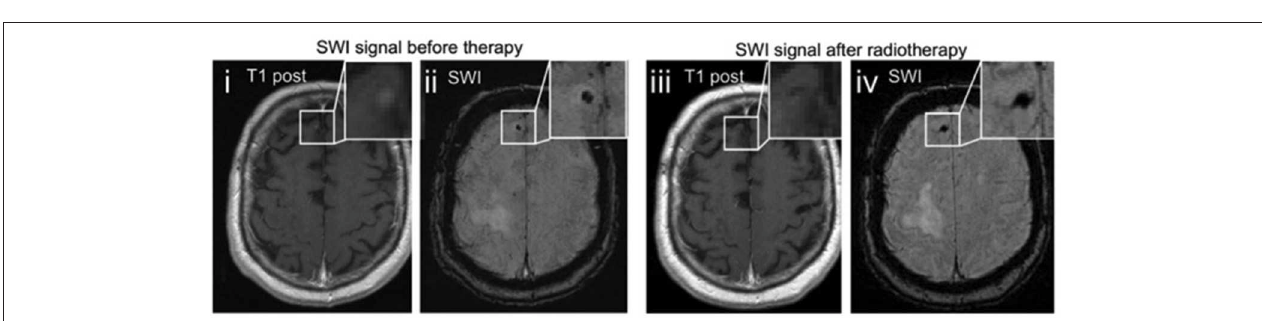
FIGURE 2 | Melanoma metastases and susceptibility. (A) Imaging findings in melanotic and amelanotic brain metastases. T1 pre-Gd-contrast (i), post-Gd-contrast administration (ii), and SWI (iii) images are shown for melanotic (A) and amelanotic (B) brain metastasis. (C) Examples of metastases with melanotic and amelanotic imaging features in a single patient. Adapted from Schwarz et al. ( 54). (B) Scatter plot showing the relation of susceptibility values ( χ ) and normalized T1w signal of melanoma metastases ( p = 0.87). The line represents a linear fit. From Straub et al. (55).